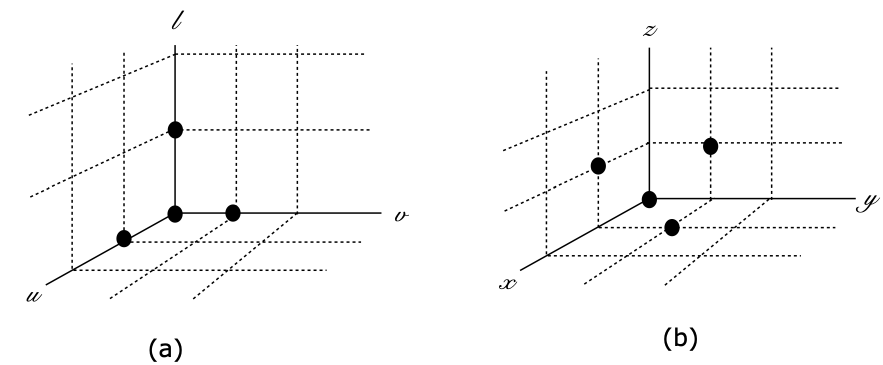
. In configuration (a) we 2